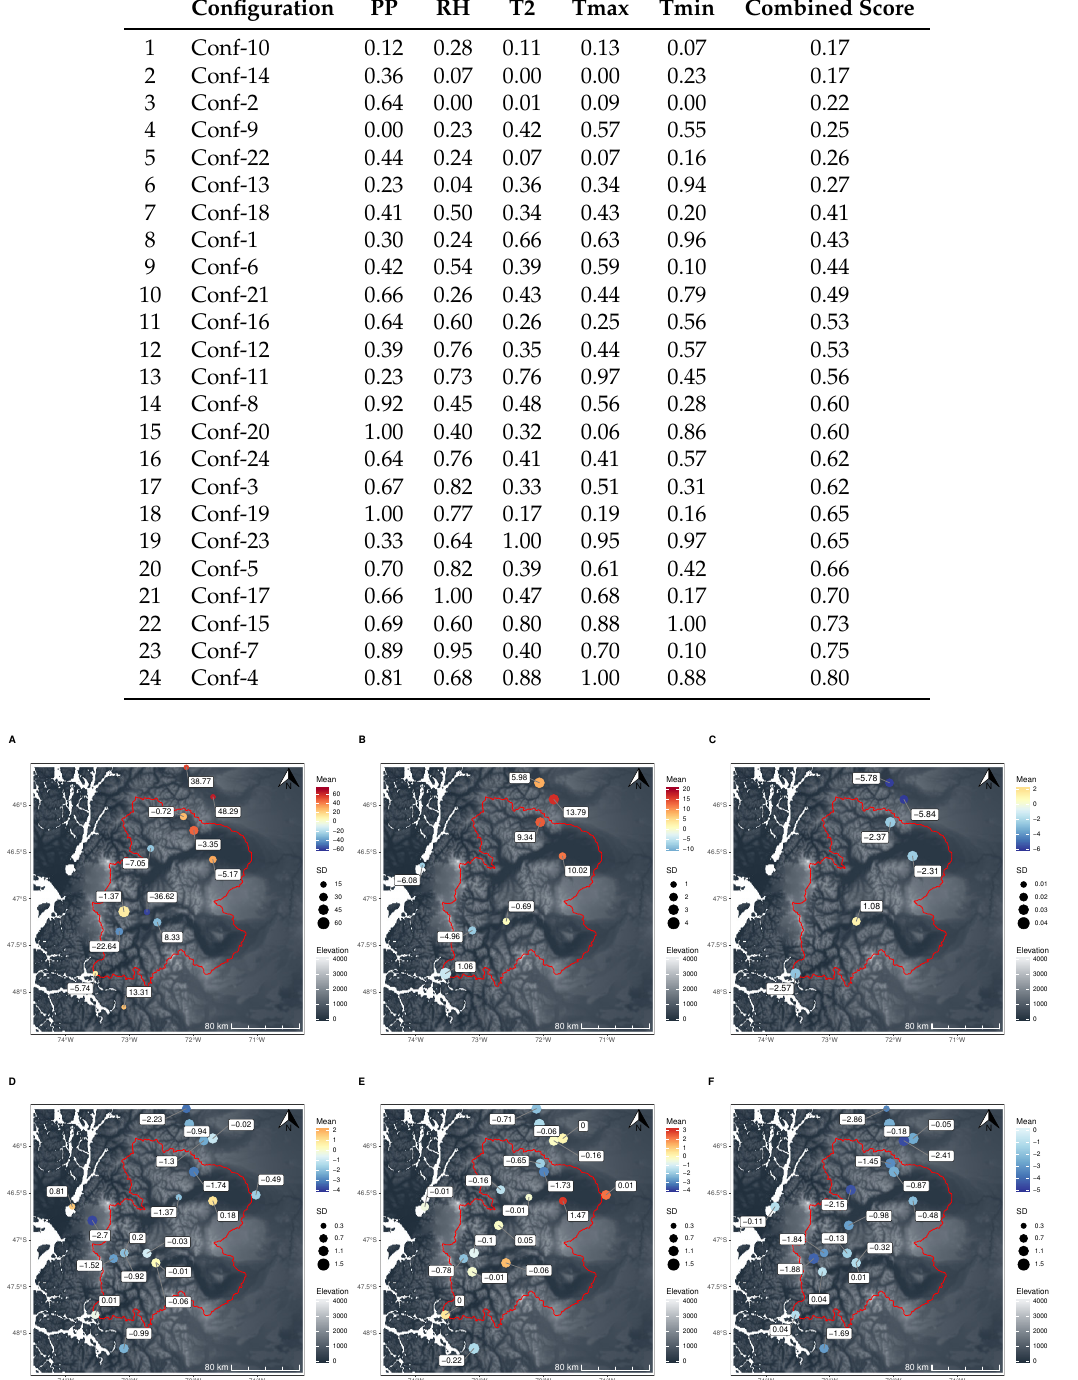
Figure 3. The maps show the average bias of the five best-ranked configurations for each variable. The color of each circle indicates the average bias; the size of the circle indicates the standard deviation, and the label shows bias for the best configuration for the variable. The variables are ( A ), precipitation (PBIAS); ( B ), relative humidity (PBIAS); ( C ), surface pressure (PBIAS); ( D ), mean temperature (BIAS); ( E ), minimum temperature (BIAS); and, ( F ), maximum temperature (BIAS). Wind speed is not included, since its performance is not good. WGS84 coordinate